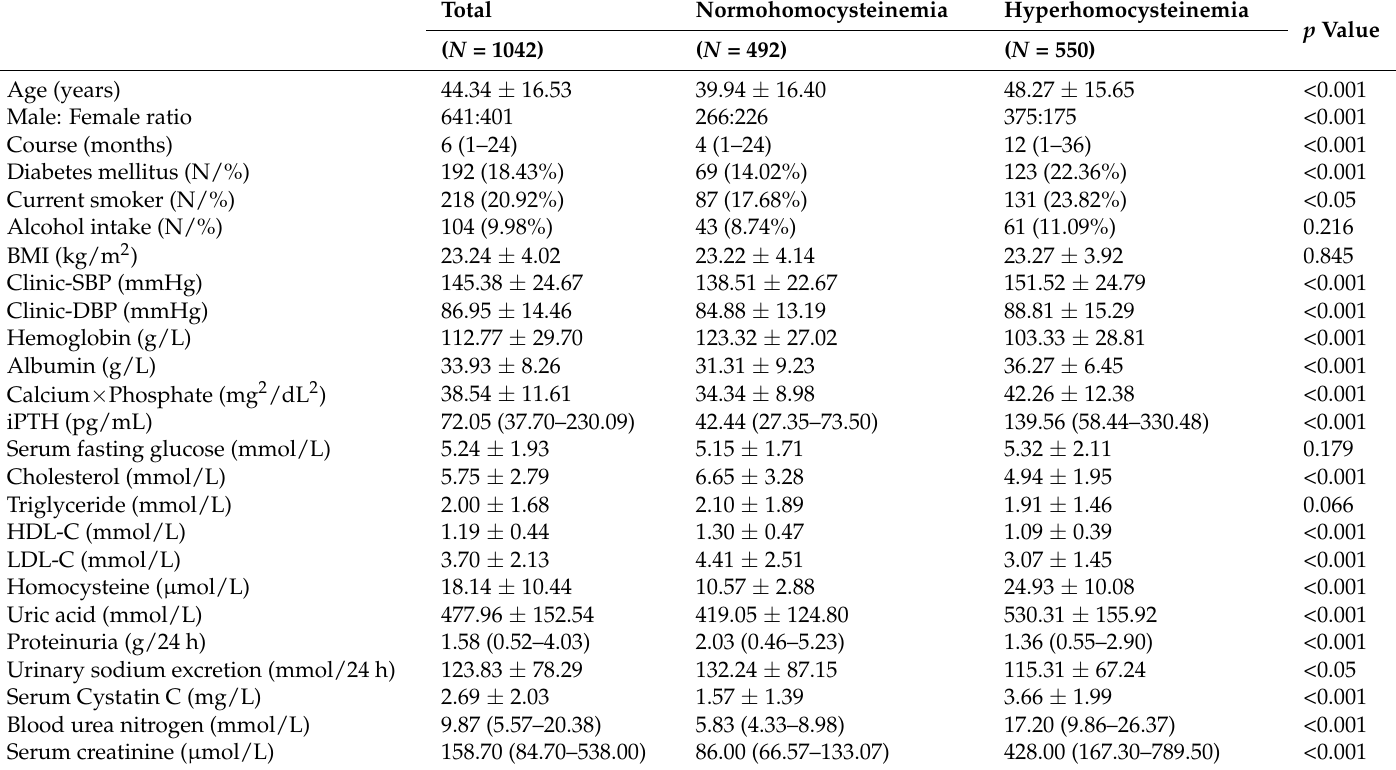
Table 1. Comparisonof demographic and clinical characteristics in Chinese CKD patientswith different plasma homocysteine